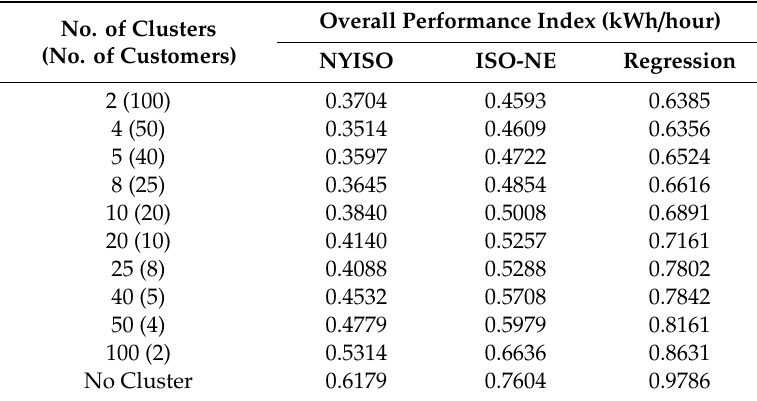
Table 7. Sensitivity analysis of number of customers in each cluster’s impact on overall performance index.